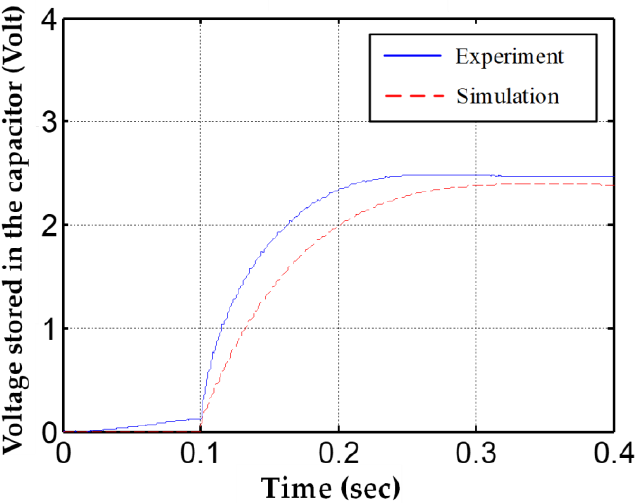
Figure 10. Measured data of voltage charge in capacitor and compared with simulation result.